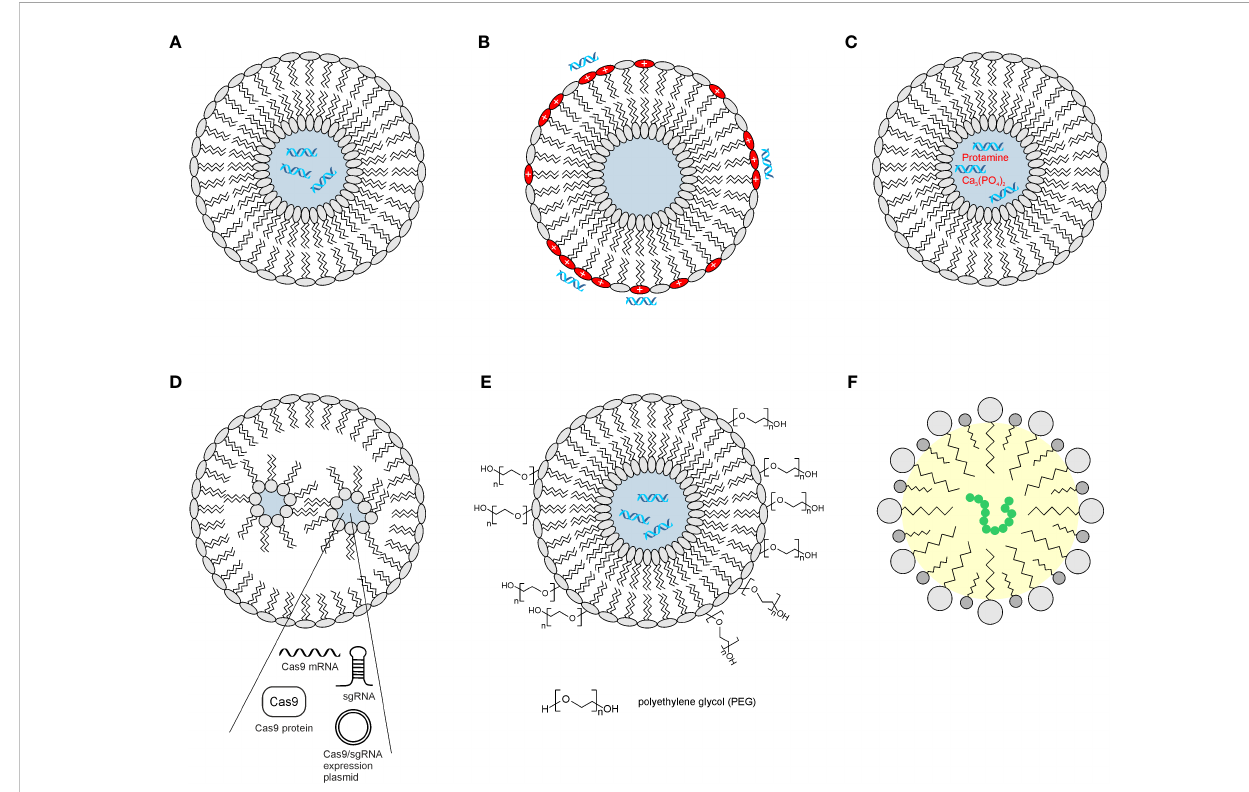
FIGURE 4 Examples of lipid-based nanocarriers. Cross-sections of spherical nanoparticles are used to encapsulate nucleic acids such as siRNAs, mRNAs, plasmids, or polypeptides. Hydrophilic and lipophilic areas are shaded in blue and yellow, respectively. (A) Neutral liposome carrying siRNAs. (B) Cationic liposome with negatively charged siRNAs at the surface. (C) Liposome with positively charged matrix in the interior complexed with negatively charged siRNAs. (D) Lipid nanoparticle encapsulating components of the CRISPR/Cas9 system, which consist either of expression plasmids, RNA, or protein. (E) Neutral liposome covered with hydrophilic polyethylene glycol for enhanced dispersion. (F) Self-nanoemulsifying drug delivery system (SNEDDS) representing an isotropic mixture of oil, surfactant (dark gray), and co-surfactant (light gray) for generation of an oil-in- water